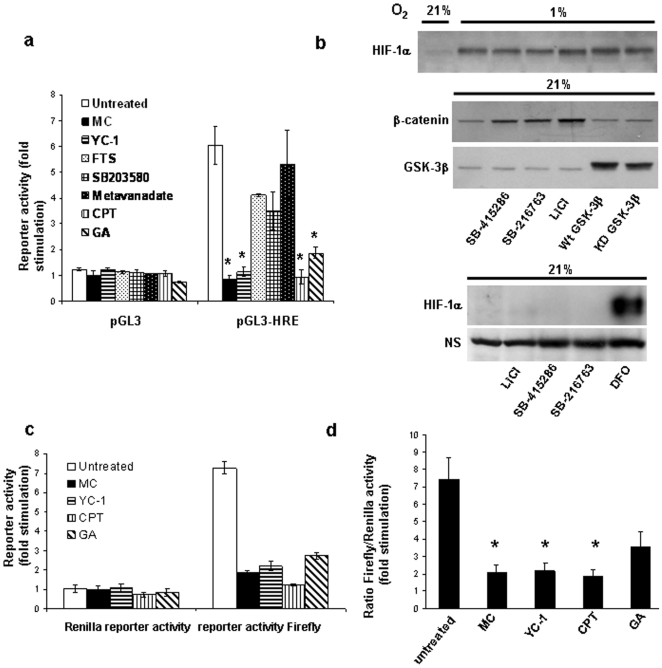
Effect of various HIF inhibitory compounds.(a) Hypoxia-dependent HIF-1α transcriptional activity was measured using HRE-dependent reporter assays as described under Materials and Methods. HEK293 cells were incubated at 1% O2 for 6 hours in the presence of the various inhibitors as indicated: mitomycin C (MC), 10 µg/ml; YC-1, 50 µM; S-trans,trans-farnesylthiosalicylic acid (FTS), 70 µM; SB203580, 20 µM; metavanadate, 50 µM; camptothecin (CPT), 2 µM; geldanamycin (GA), 10 µM. (a) Luminescence was measured and fold stimulation was obtained by normalizing the relative luciferase activity of cells cultured under hypoxic conditions to those of nontreated cells cultured under normoxic conditions. Results represent mean ± SEM of three independent experiments. Student's t test analysis of the ratio of fold stimulation obtained for cells transfected with pGL3-HRE to those transfected with the promoter-less pGL3 empty vector showed that treatment with MC, YC-1, CPT and GA significantly (p<0.05, denoted as an asterisk *, n = 3) reduced luciferase activity compared to untreated control. (b) HEK293 cells were transfected for two days with wild type or kinase-dead (K85R) GSK-3β expression plasmids, or treated with 20 µM SB-415286, 5 µM SB-216763, or 30 mM LiCl for 6 hours. In the upper panel, the cells were incubated at 1% O2 during the drug exposure. Cytosolic β-catenin concentrations were measured by lysing cells in hypotonic lysis buffer as previously described [26] In the bottom panel, 200 µM desferrioxamine (DFO) was used as a positive control for normoxic HIF-1α induction and a HIF-1α reactive non-specific (NS) band was used to demonstrate equal protein loading. (c,d) To study the effects of mitomycin C, YC-1, camptothecin and geldanamycin on HIF transcriptional activity in more detail, firefly and renilla luciferase activity of cells cotransfected with pGL3-HRE and pRL-CMV and incubated under hypoxic condition in the presence of MC, YC-1, CPT and GA (as in Fig. 1a) was measured. The renilla and firefly luciferase activities are shown in (c), the ratio of firefly to renilla luciferase activity in (d). The results are expressed as fold stimulation relative to the activity in nontreated cells under normoxic conditions. Statistical significance (p<0.05, n = 3) is indicated with an asterisk in the bottom panel.